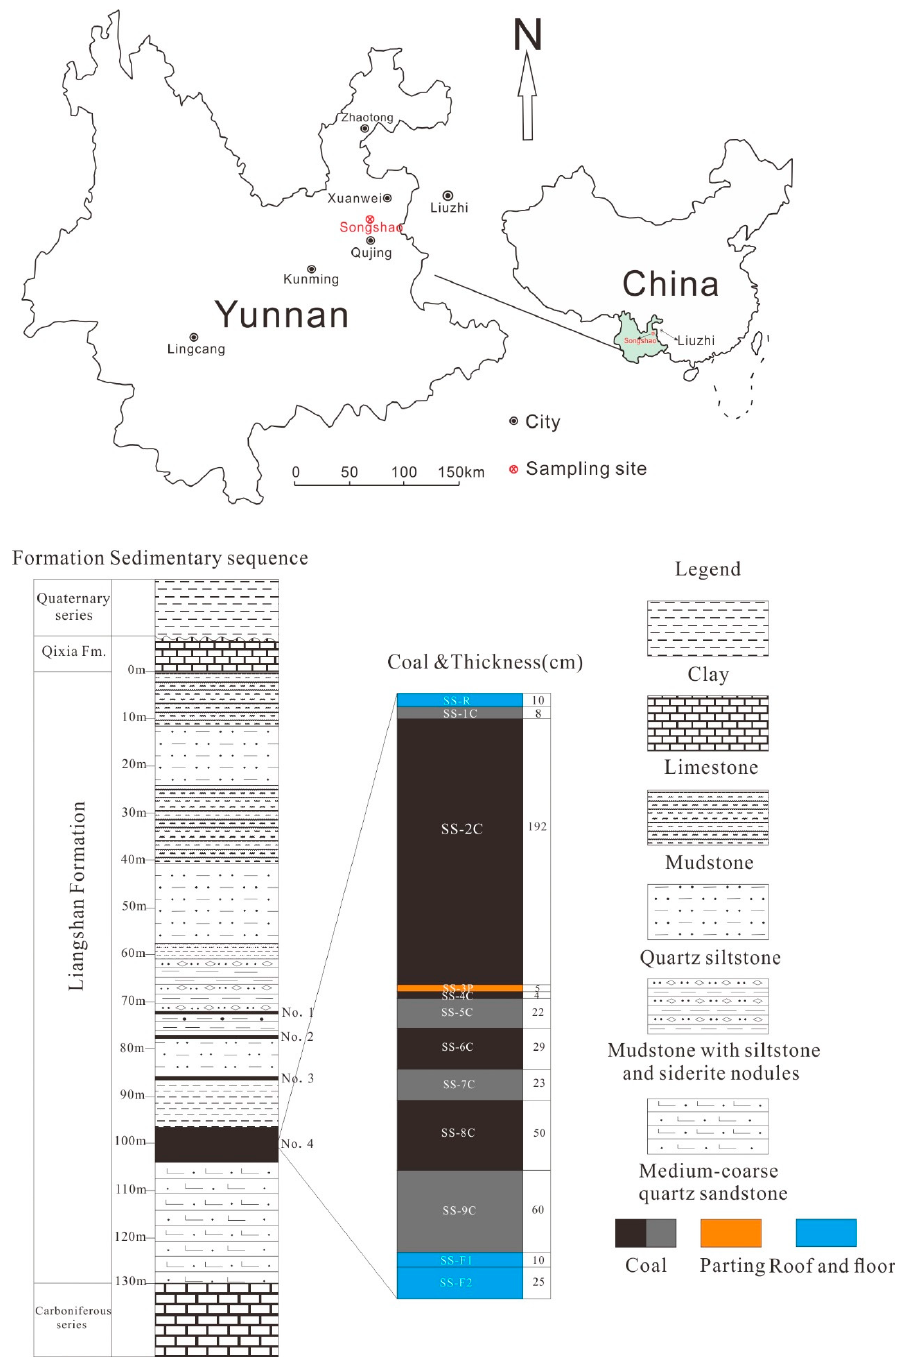
Figure 1. Location and sedimentary sequence of the Songshao Mine, Eastern Yunnan Province, China.